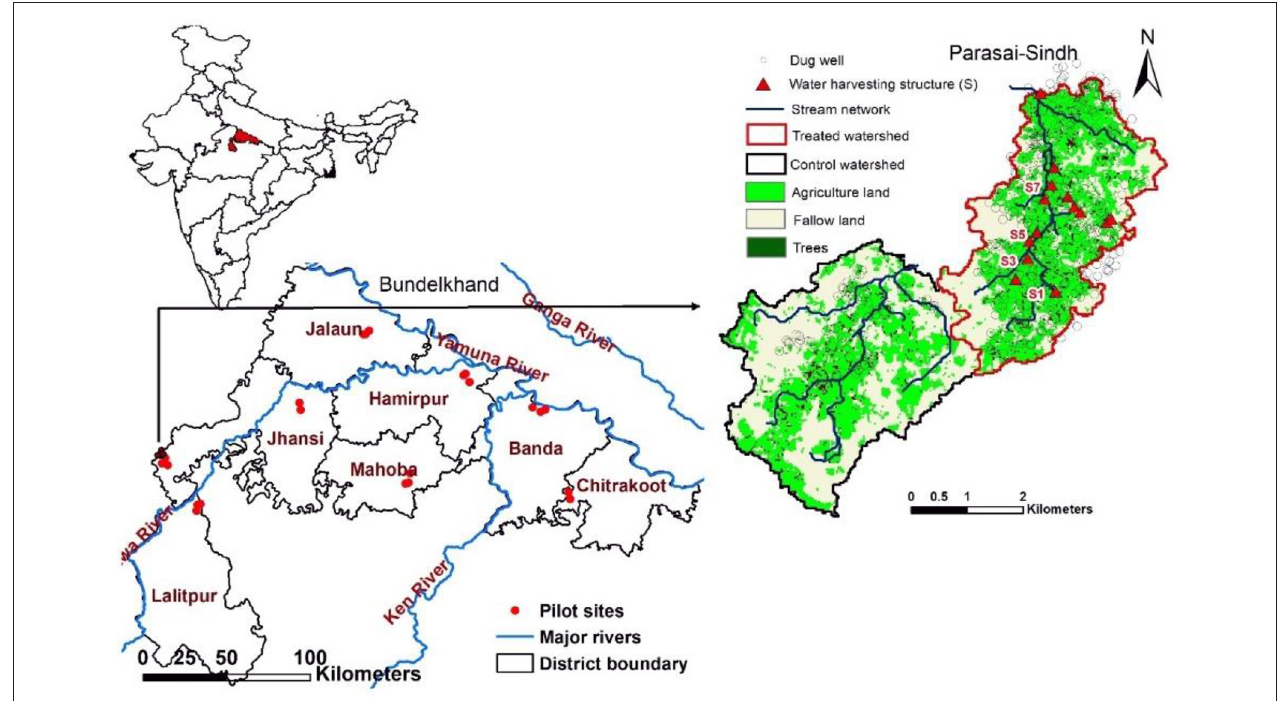
FIGURE 1 | Location map ( on left ) shows study area indicating major rivers, seven districts of Bundelkhand region along with pilot villages; enlarged map ( on right ) shows Parasai-Sindh watershed of Jhansi district, which was intensively monitored along with the control